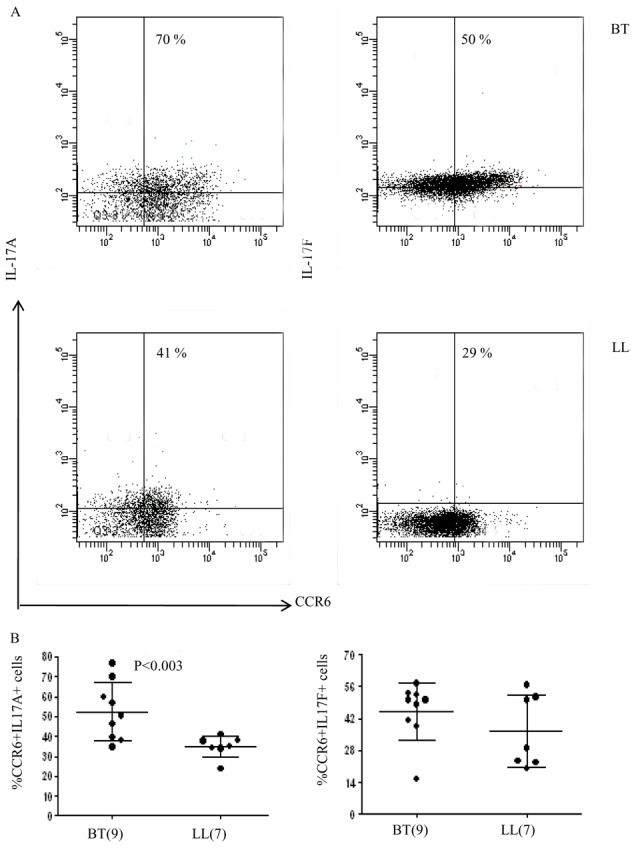
IL 17 producing cells belong to CD3+CD4+CCR6+ effector T cell lineage.A. Representative flow cytometry analysis on antigen stimulated PBMC of one each of BT and LL patients (see Materials and Methods). CD3+ gated CD4+ cells were examined for the presence of intracellular IL-17 and surface CCR6 (see Materials and Methods). As may be seen both IL-17A and IL-17F containing cells showed CCR6. The % of IL 17A/F+ CCR6+ cells was higher in BT as compared to LL as indicated in the figure. % of cells is given in the upper quadrant of the figure. B. Scattergram of BT and LL subjects showing Mean%+SD of IL-17A/F+CCR6+ cells which was significantly higher for IL-17A in BT as compared to LL as indicated by p values given in the figure. Abbreviations and legend as in figure 4.